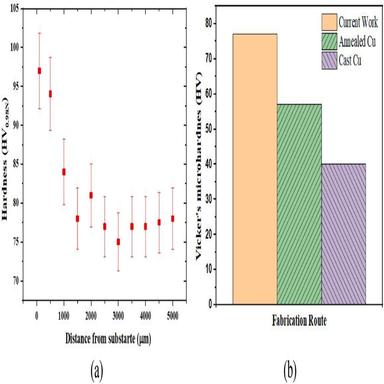
Micro-hardness of LDED built Cu (a) Along build direction (b) Comparison of micro-hardness of Cu.